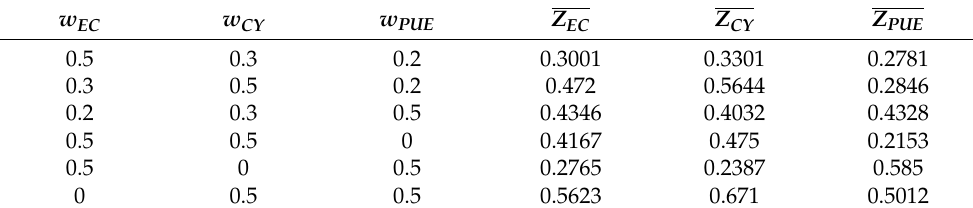
Table 17. Effect of the weights of the total objective function on the different sub-objectives.